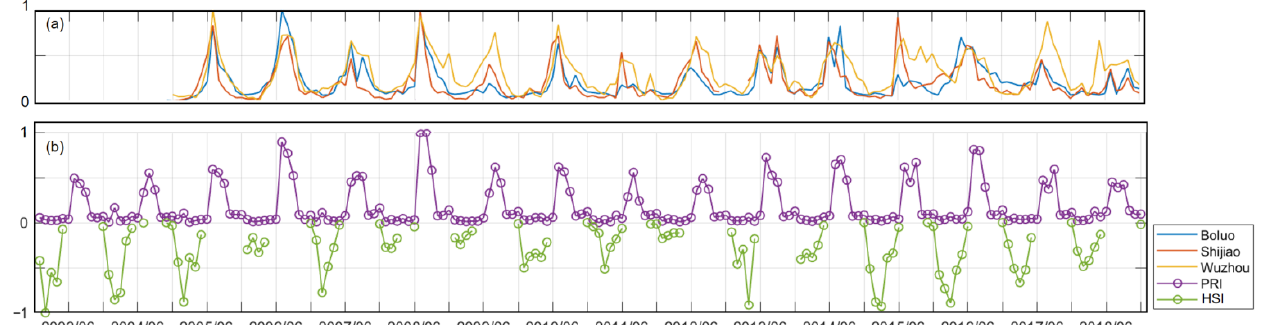
Figure 12. Relative river discharges of the three tributaries of the Pearl River and the standardized monthly Pearl River plume index (PRI) and sea surface high salinity index (HSI) in the northern South China Sea over 2003–2018. ( a ) Relative river discharges, in which Station Boluo represents the East River, Station Shijiao stands for the North River, and Station Wuzhou represents the West River, and ( b ) temporal changes in the standardized monthly PRI and HSI in the northern SCS. The HSI is not shown where there is no Kuroshio intrusion, i.e., SSS < 34.25.